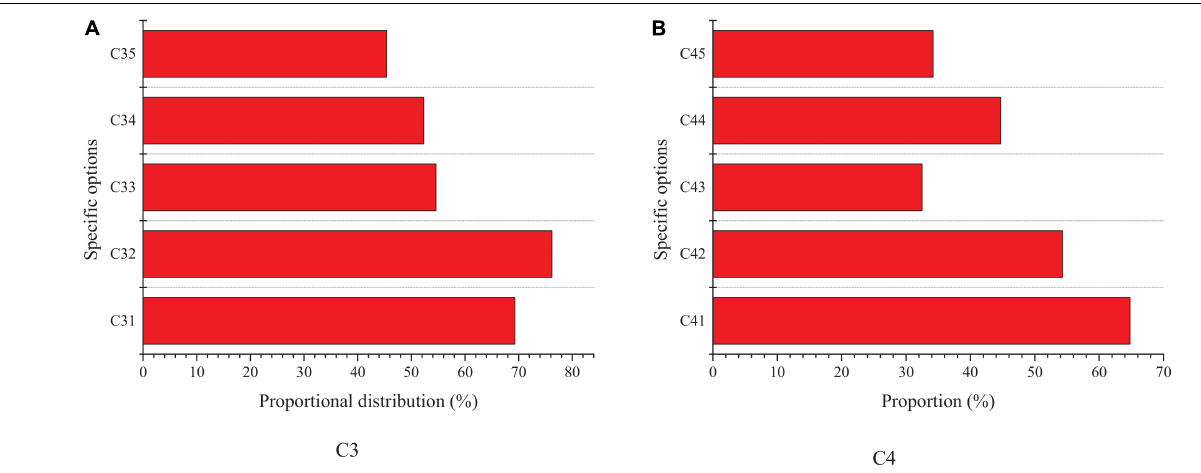
FIGURE 5 | Survey results based on (A) C3 and (B) C4.